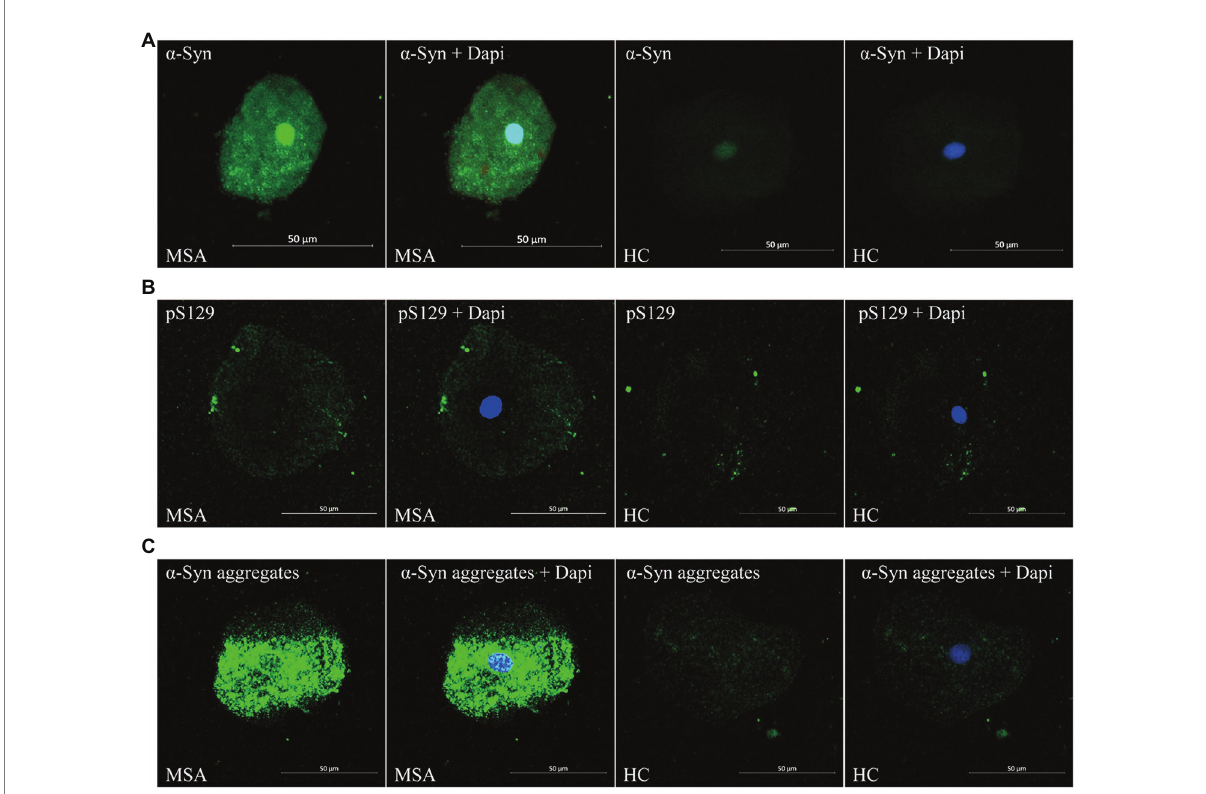
FIGURE 1 Confocal microscopy (×40) study of α -Syn (A) , pS129 (B) , and α -Syn aggregates (C) expression pattern in oral mucosal cells of MSA patients and controls. DAPI: bule. α -Syn: green. Scale bar: 50 μ m. MSA, Multiple System Atrophy; α -Syn, α -synuclein; pS129, phosphorylated α -Syn at